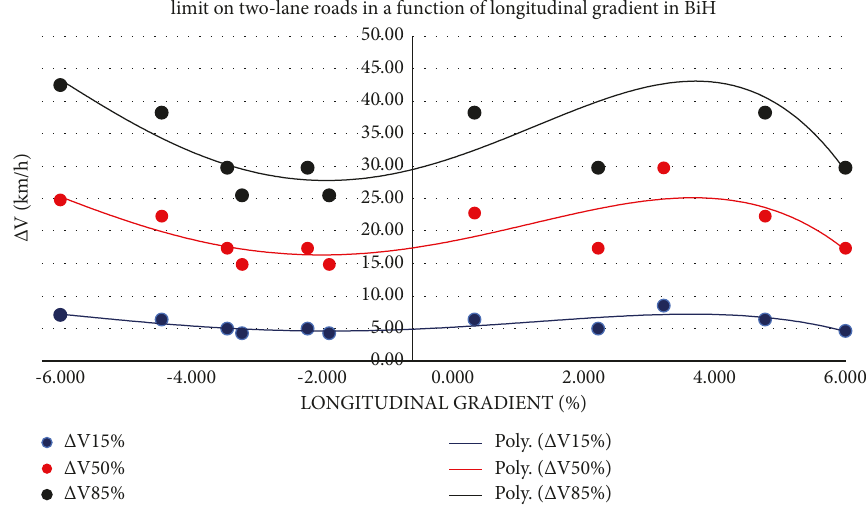
Figure 5: Δ V 15%, 50%, and 85% as a function of longitudinal gradient. Table 7: Analytical model of 15%, 50%, and 85% speed deviations from the speed limit on two-lane roads in BiH. 15% deviation of values Δ V Correlation coefficient: R 2 � 0.614 Correlation coefficient: R 2 � 0.586 Correlation coefficient: R 2 � 0.596